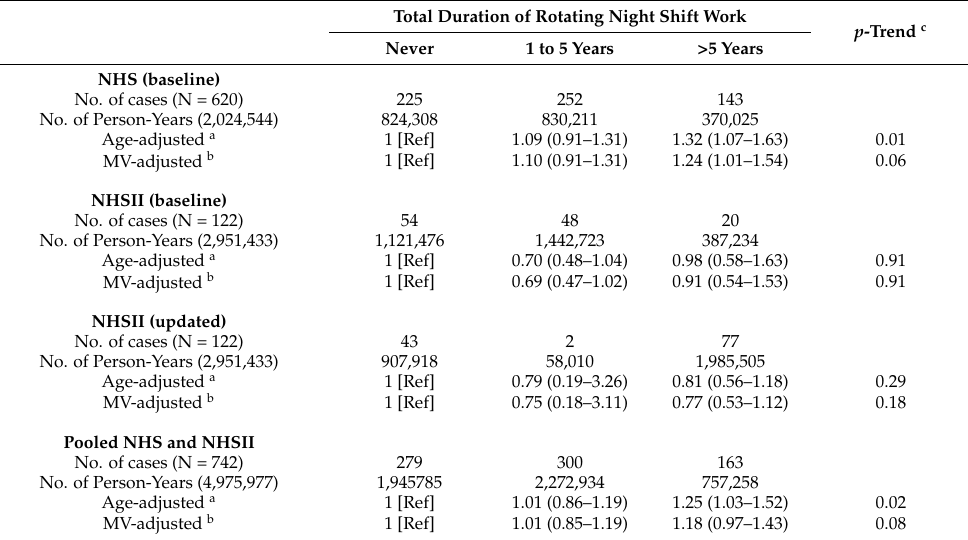
Table 2. Hazard ratios and 95% confidence intervals (CI) of bladder cancer risk according to total duration of rotating night shift work in the NHS, NHS II, and pooled study population. Total Duration of Rotating Night Shift Work p -Trend c Never 1 to 5 Years >5 Years